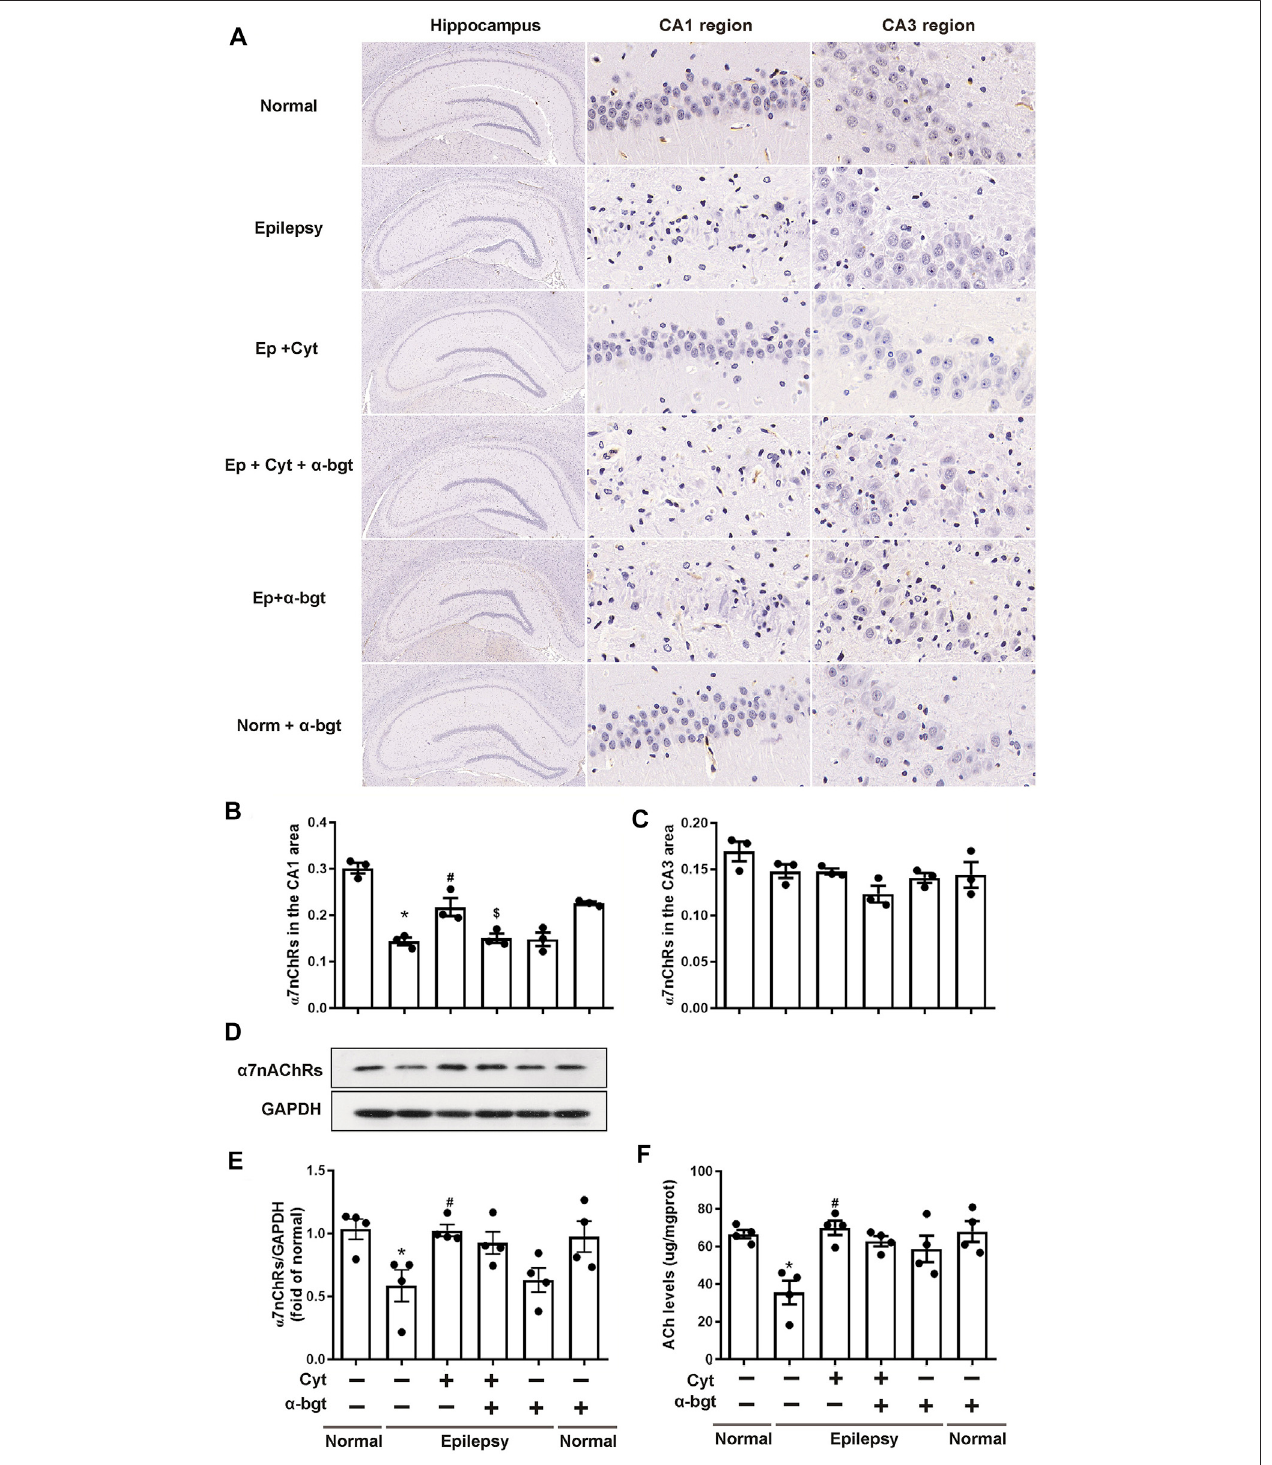
FIGURE5| Cytisine enhances cholinergic transmissionin thehippocampi ofepileptic rats. A – C: The expression of α 7nAChRs inthe hippocampus wasstained by immunohistochemistry.Statisticalresultsareasfollows: F (5,12) (cid:1) 26.033, p < 0.05, n (cid:1) 3;normalvs.epilepsy, * p < 0.05;epilepsyvs.epilepsy+Cyt, # p < 0.05;epilepsy +Cytvs. epilepsy+Cyt+ α -bgt, $ p < 0.05. D – E: Theexpression of α 7nAChRsinthehippocampus wasanalyzed byWesternblotting.Statisticalresults areasfollows: F (5,18) (cid:1) 4.271, p < 0.05, n (cid:1) 4; normal vs. epilepsy, * p < 0.05; epilepsy vs. epilepsy + Cyt, # p < 0.05. F: ACh levels in the hippocampus were measured by colorimetry. Statistical results are as follows: F (5,18) (cid:1) 6.705, p < 0.05, n (cid:1) 4; normal vs. epilepsy, * p < 0.05; epilepsy vs. epilepsy + Cyt, # p < 0.05.